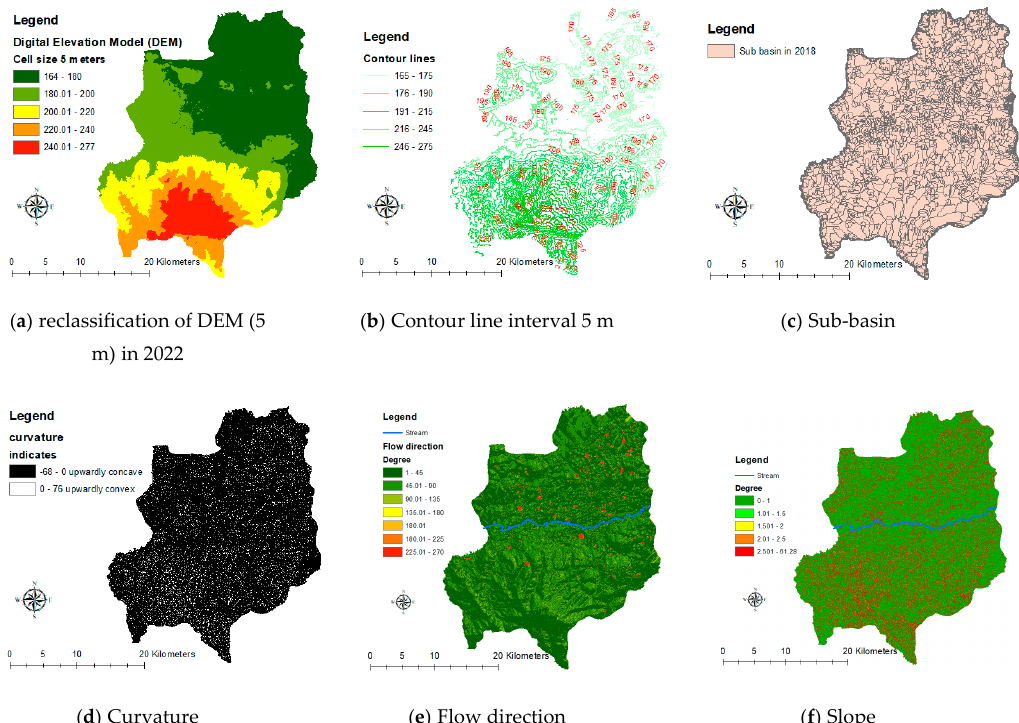
Figure 4. Maps of hydrological data ( a – f ) to use for independent variables extraction of FRS-GWR model in 2022.